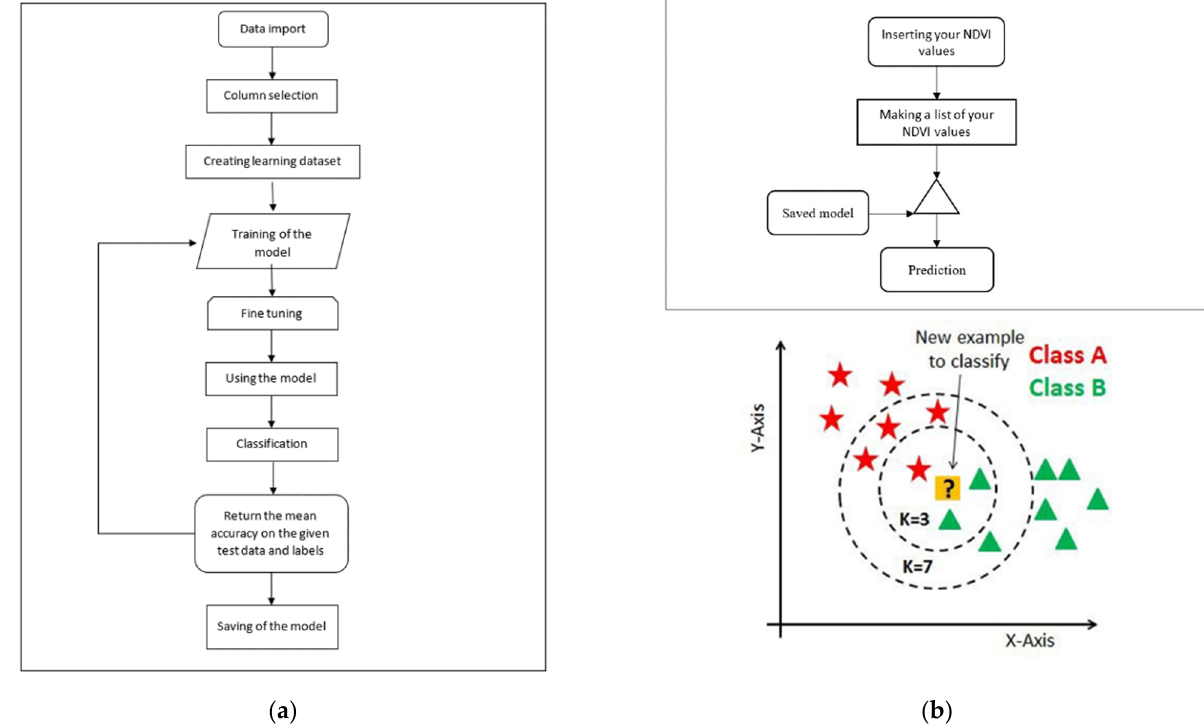
Figure 1. ( a ) The analysis of the training algorithm; ( b ) top : Identification of crop type by machine learning algorithm, bottom : KNN module on figure (source: https://medium.com/, (accessed on 30 November 2021)).